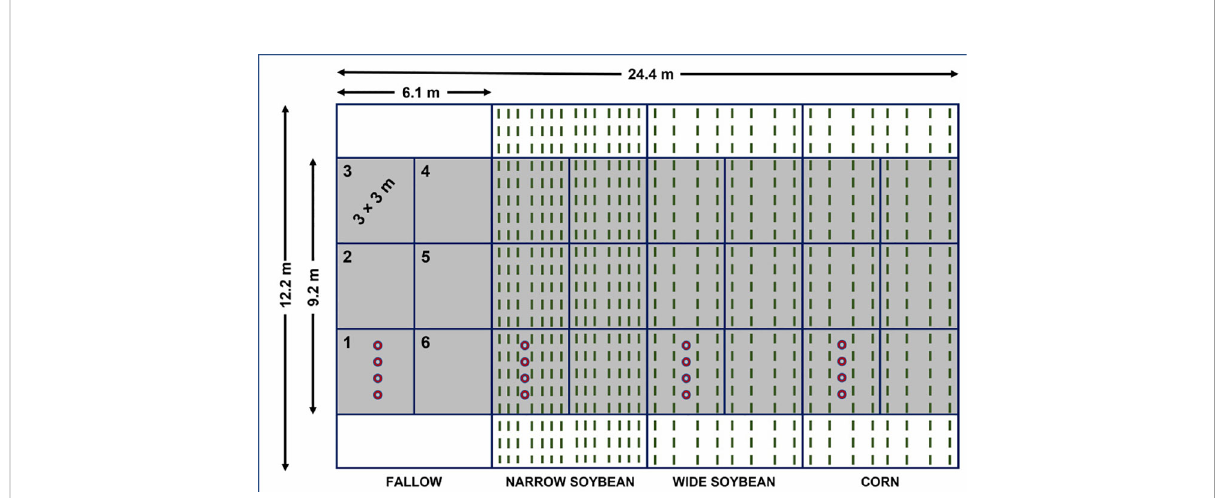
FIGURE 1 Example illustrating placement of transplanted waterhemp seedlings in fallow, narrow and wide soybean, and corn in the randomized experimental block. Numbers starting from 1 to 6 represent respective transplant timings. Transplanted waterhemp seedlings and their placement inside the crop rows are presented as red circles. Green dashed lines illustrate soybean rows (narrow [38 cm] and wide [76 cm]) and corn (76